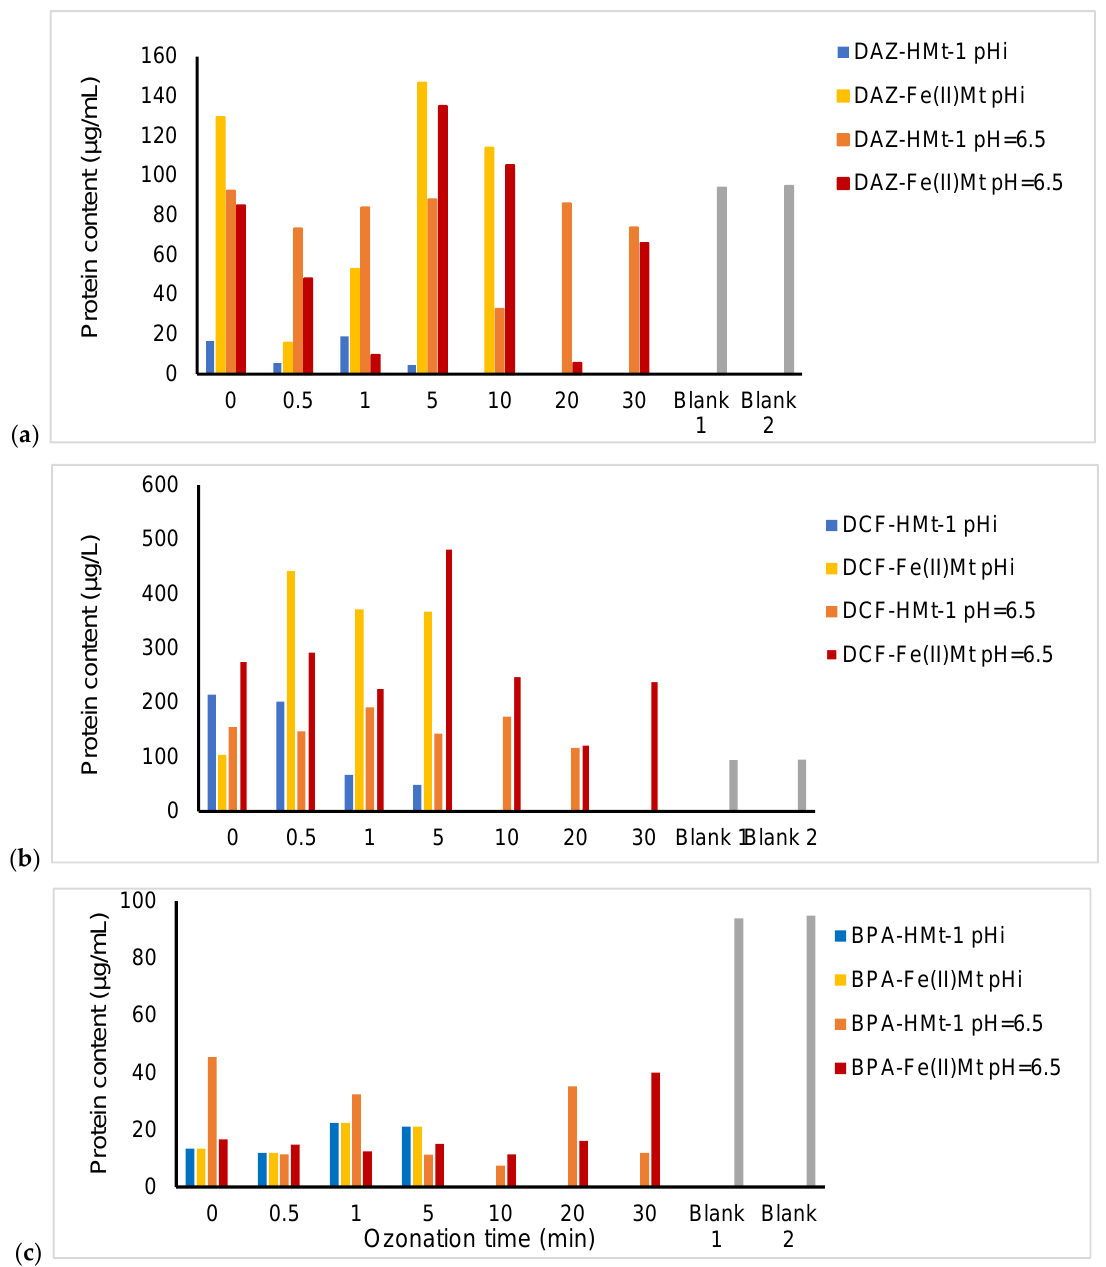
Figure 8. Effect of the ozonation time of the aqueous solutions of DAZ ( a ), DCF ( b ) and BPA ( c ) at room temperature on the protein content of Lemna minor . Ozone throughput: 600 mg h −1 , Catalyst amount: 40 mg; Aliquot volume = 30 mL. The control sample contains only Lemna minor and was not contacted with ozonation mixtures. The toxicity tests were achieved i . at constant pH 6.5 adjusted after ozonation and ii . at the pH of the SIS mixture with the solution of the organic substrate before and after ozonation at different times.